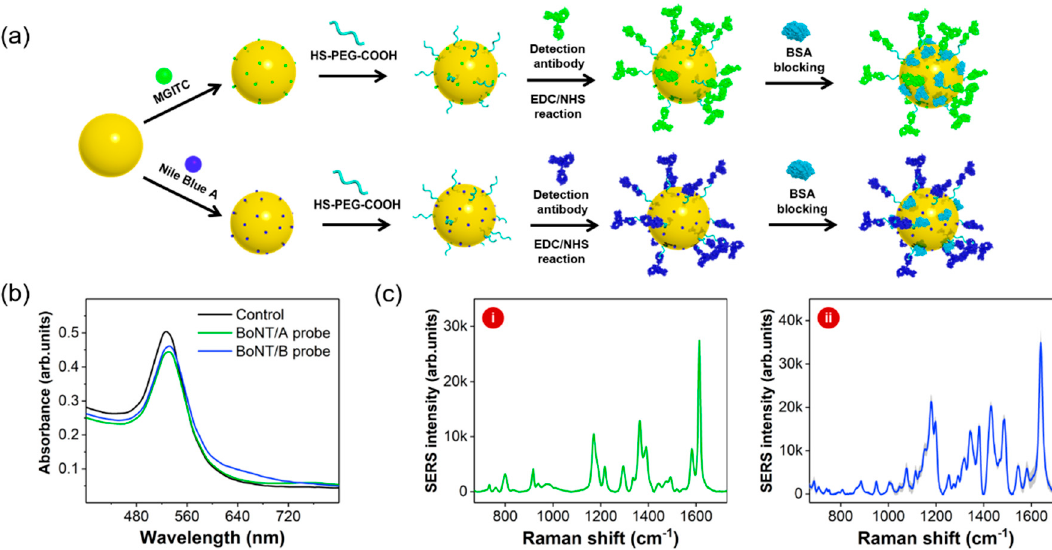
Figure 1. ( a ) Sequential process for the synthesis of two different types of BoNT SERS nanotags. ( b ) UV/Vis spectra for AuNPs (black), BoNT/A (green), and BoNT/B (blue) SERS nanotags. ( c ) Raman spectra for BoNT/A (i) and BoNT/B (ii) SERS nanotags.